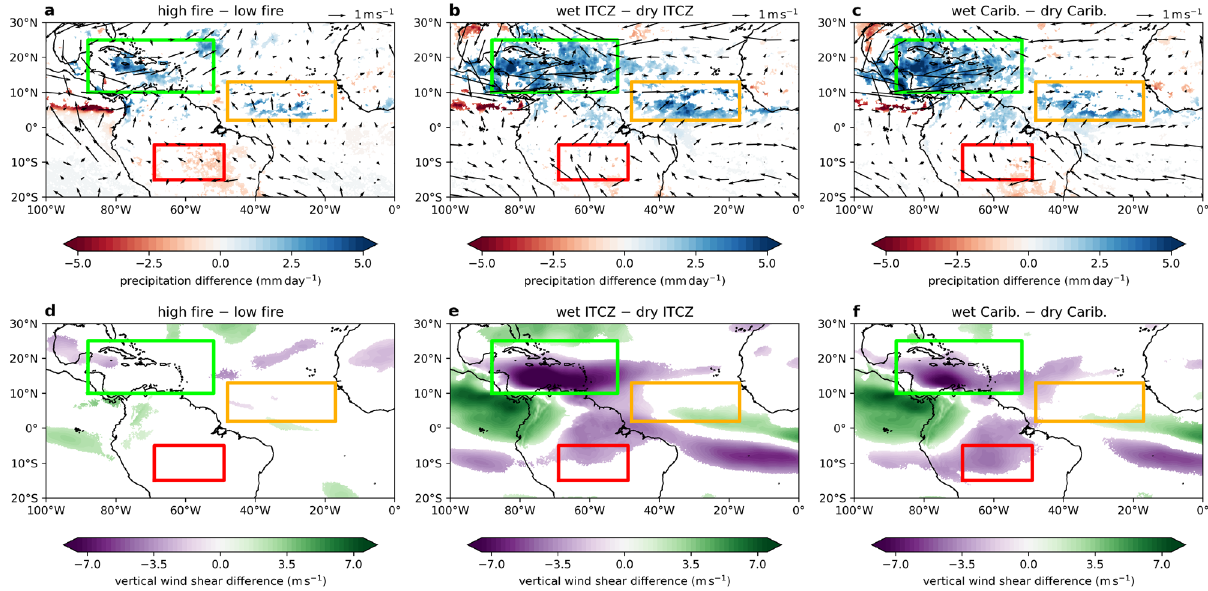
Figure 4. Horizontal wind, precipitation and vertical wind shear anomalies. ( a )–( c ): Composite difference for ASO of horizontal wind at 850 hPa and precipitation (significant at 95% confidence interval) of the highest and lowest 5 years between 2001 and 2018 ranked by ( a ) ASO Amazon fire count, ( b ) ASO Atlantic ITCZ precipitation and ( c ) ASO Caribbean precipitation. ( d )–( f ): Same as ( a )–( c ) except for 850–200 hPa vertical wind shear. ( a )–( f ): The boxes are Amazon (red), Atlantic ITCZ (orange) and Caribbean